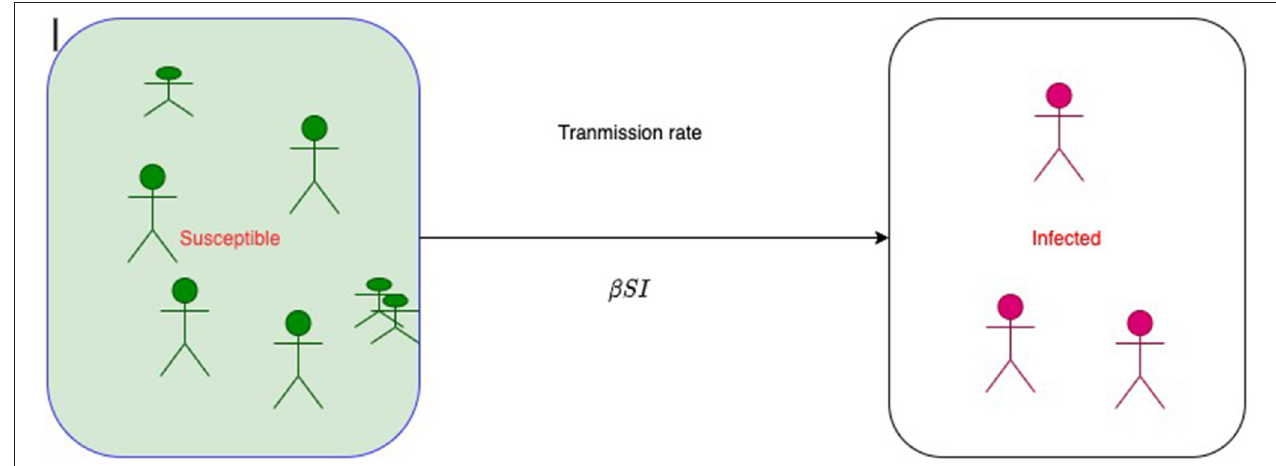
FIGURE 1 | A simple SI model without demography. β is per capita contact